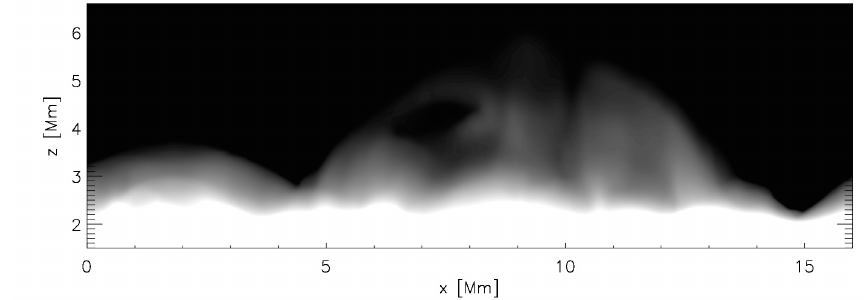
Figure 6: Synthetic Hinode/SOT Ca ii H image from the flux emergence simulation by Mart´ınez-Sykora et al. (2009). The line-of-sight is taken to be parallel to the solar surface to mimic observations of such regions at the solar limb. Image reproduced with permission, copyright by